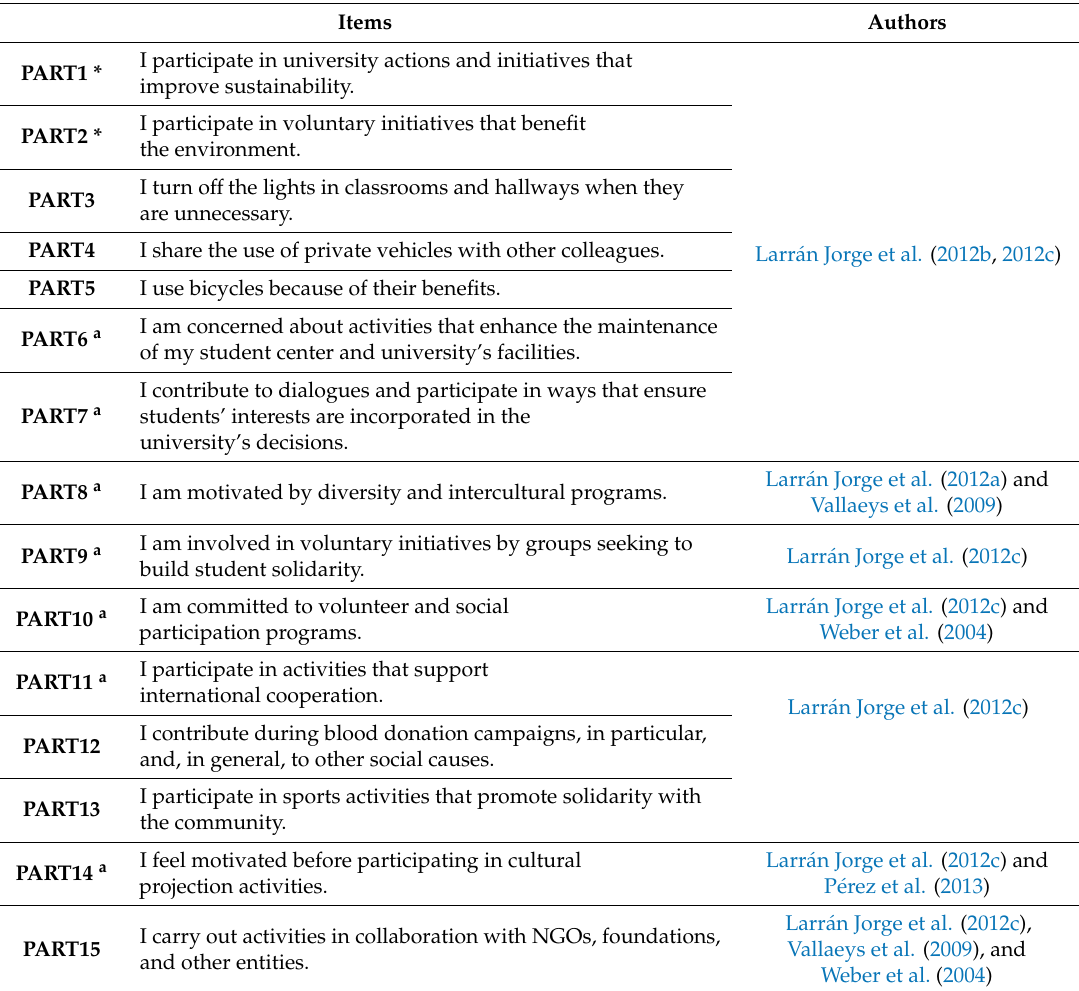
Table 2. Indicators of student participation in university